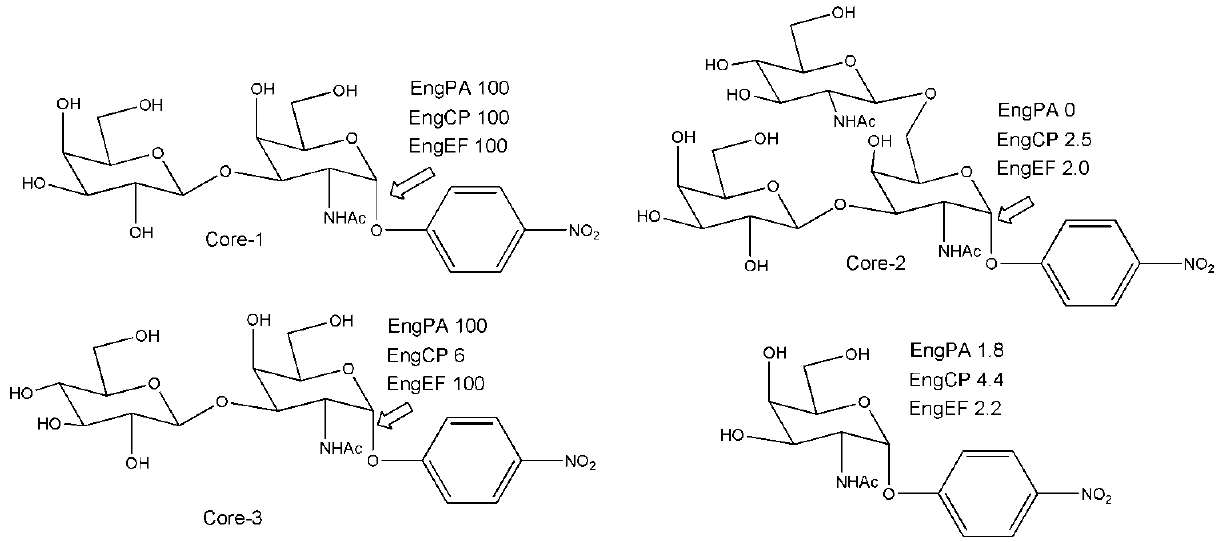
Figure 2. Substrates and percentages of products liberated at the link indicated by each single